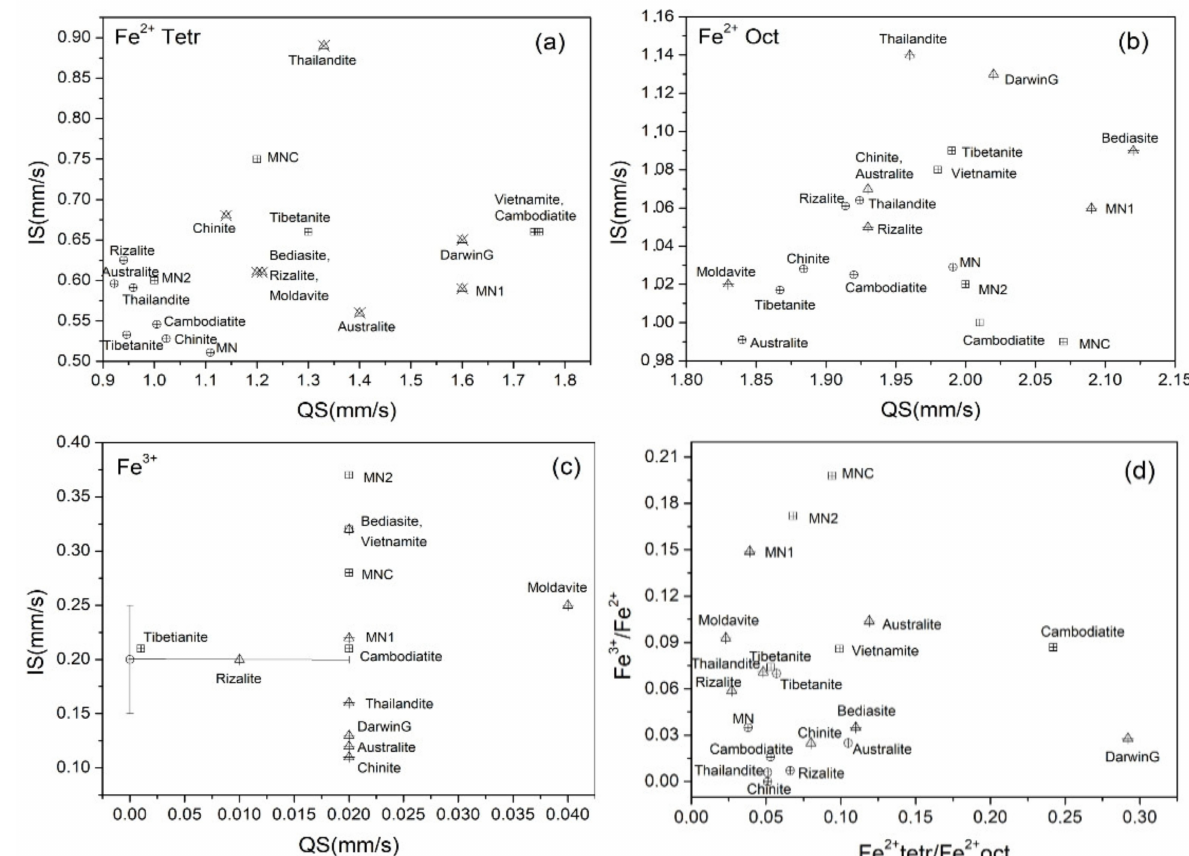
Figure 22. Average hyperfine parameters of analyzed tektites plotted with data from Table 8 (triangles) and Table 9 (squares) and Dunlap et al. [54] (circles). ( a ) Fe 2+ tetr; ( b ) Fe 2+ oct; ( c ) Fe 3+ ; ( d ) (Fe 3+ / Fe 2+ ) vs (Fe 2+ tetr/ Fe 2+ oct). MN1: Laos Muong-Nong 1; MN2: Laos Muong-Nong 2; MNC: Chinese